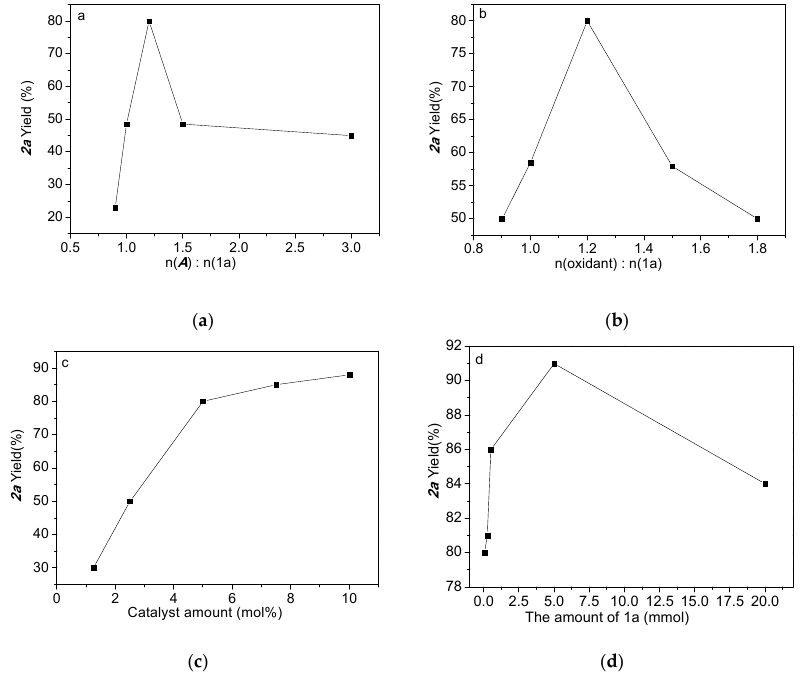
Figure 2. Effect of condition parameters on yield of intermediate product 2a ; ( a ) Effect of A amount on 2 a yield, ( b ) Effect of 8 ‐ Me ‐ quinoline N ‐ oxides amount on 2 a yield, ( c ) Effect of catalysts amount on 2 a yield, ( d ) Effect of 1a amount on 2 a yield.